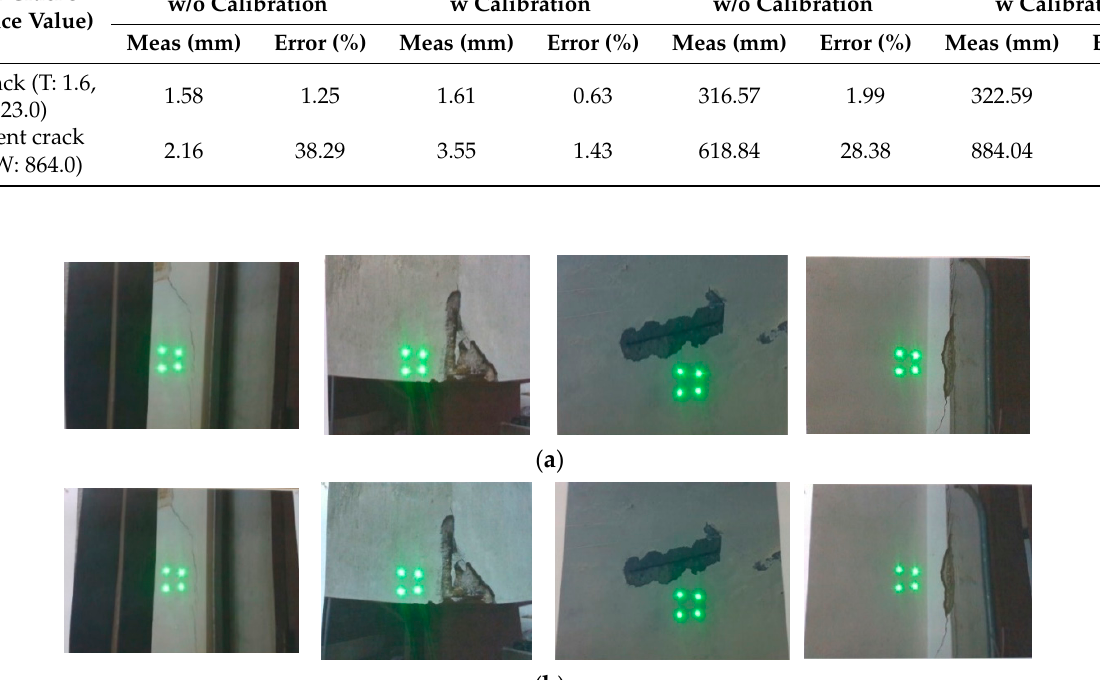
Figure 9. Image integration using the stitching algorithm. The captured images including ( a ) shear and ( b ) settlement cracks, and the merged image after performing homography calculation and image stitching. Table 2. Quantification results using integrated crack images.